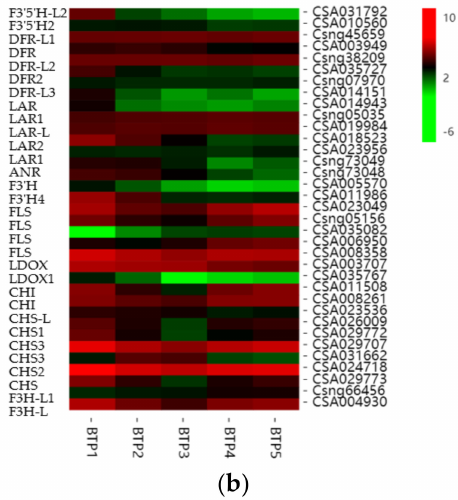
Figure 7. Key structural genes and their expression level of involved in anthocyanin biosynthesis pathway. ( A ) the number of DEGs involved in anthocyanin biosynthetic pathway. ( B ) The heatmap of key structural genes and expression level. The color scale represents the log2 values (FPKM) of the tea flower during the BTP1, BTP2, BTP3, BTP4, and BTP5 stages (from left to